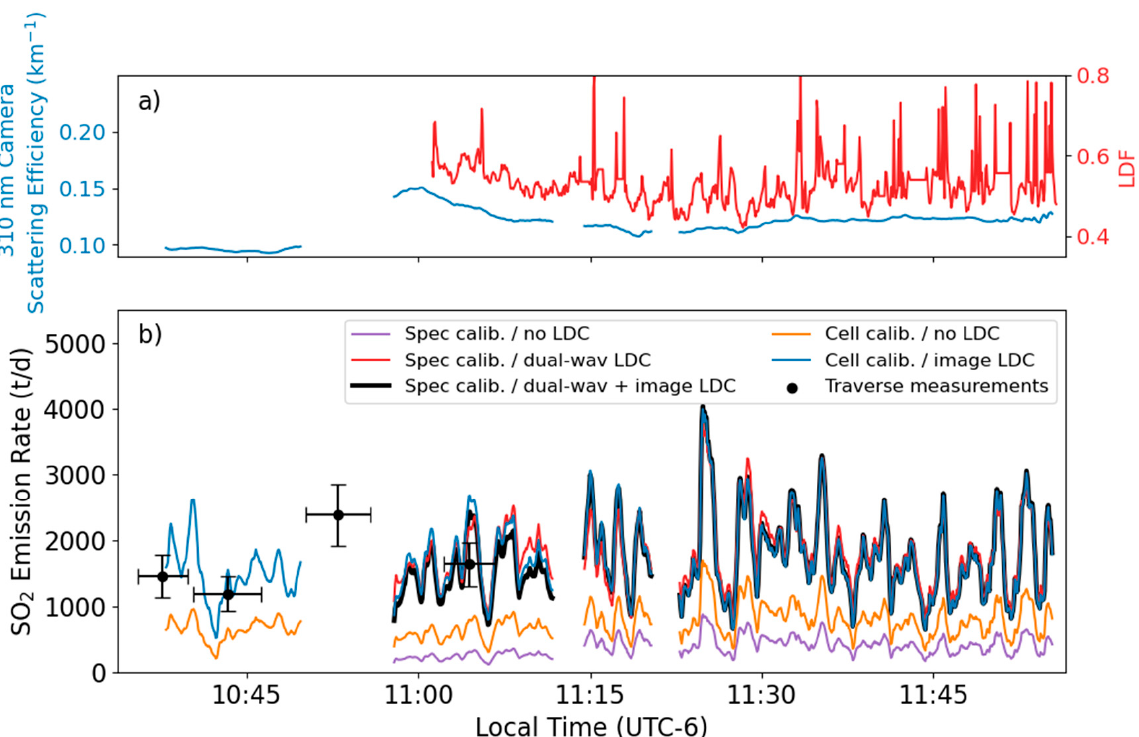
Figure 7. ( a ) Scattering efficiency for the image-based correction (blue) and the light dilution factor (LDF) for the spectrometer correction (red) plotted for the duration of the measurement period on the 15 January 2018; ( b ) spectrometer-calibrated (purple and red) and cell-calibrated SO 2 emission rates (orange and blue) for processed camera data. The spectrometer- calibrated emission rate has been light dilution-corrected (LDC) using dual-waveband modelling (red), whilst the cell- calibrated emission rate had been light dilution-corrected using an image-based correction. Our suggested methodology of combining spectrometer calibration (dual-waveband corrected) with image-based corrections is shown as the thick black line. Traverse measurements (black points with error bars) are also shown as a